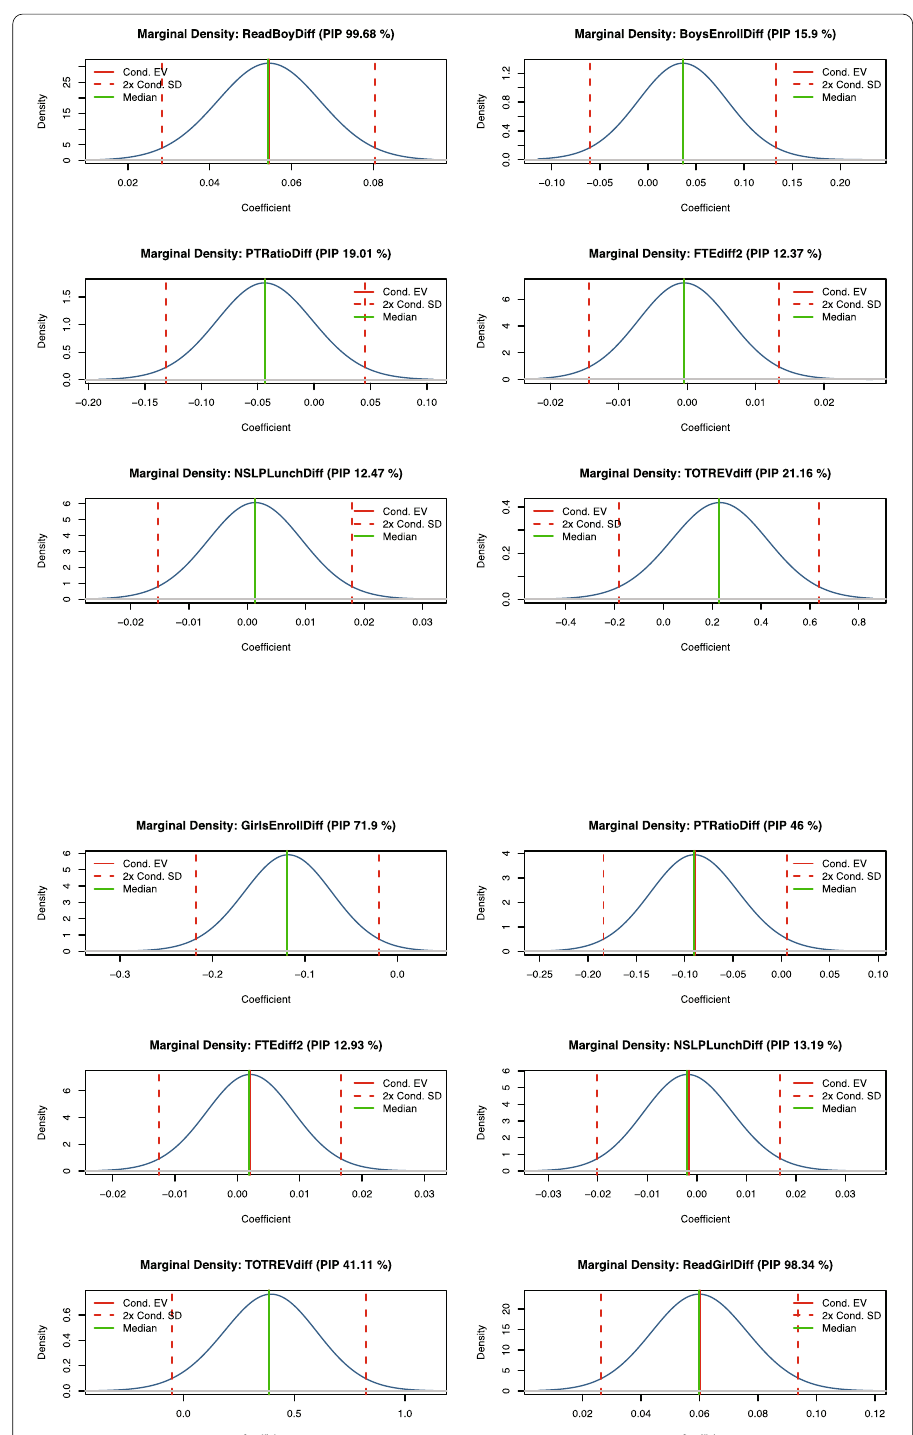
Fig. 3 Marginal posterior density plots and posterior inclusion probabilities for boys (top) and girls